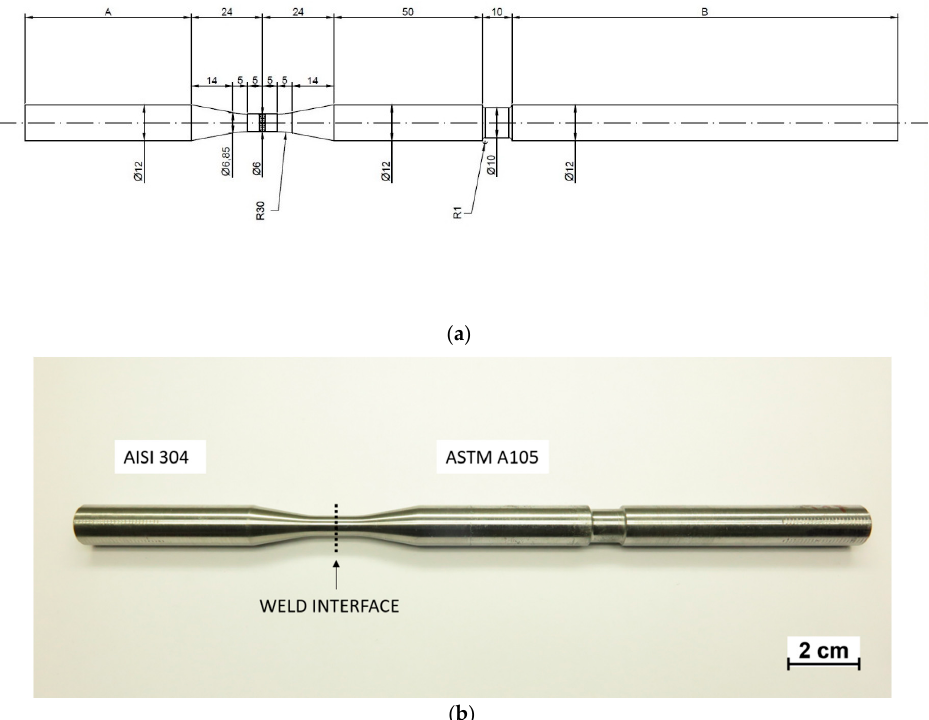
Figure 1. ( a ) Selected specimen design for fatigue tests (unit: mm); ( b ) image of the as-made sample.